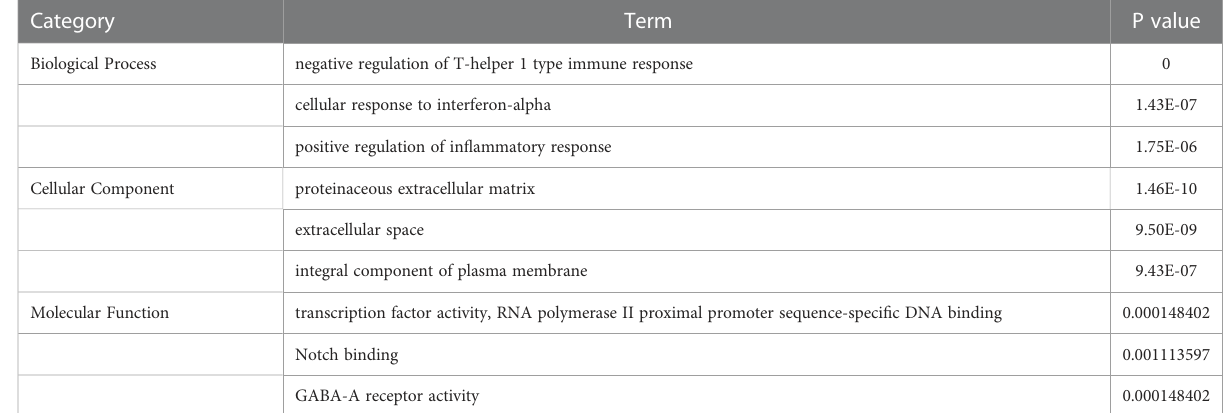
TABLE 4 GO term list of signi fi cantly differentially expressed genes between the experimental group at 24 h and the control group. Category